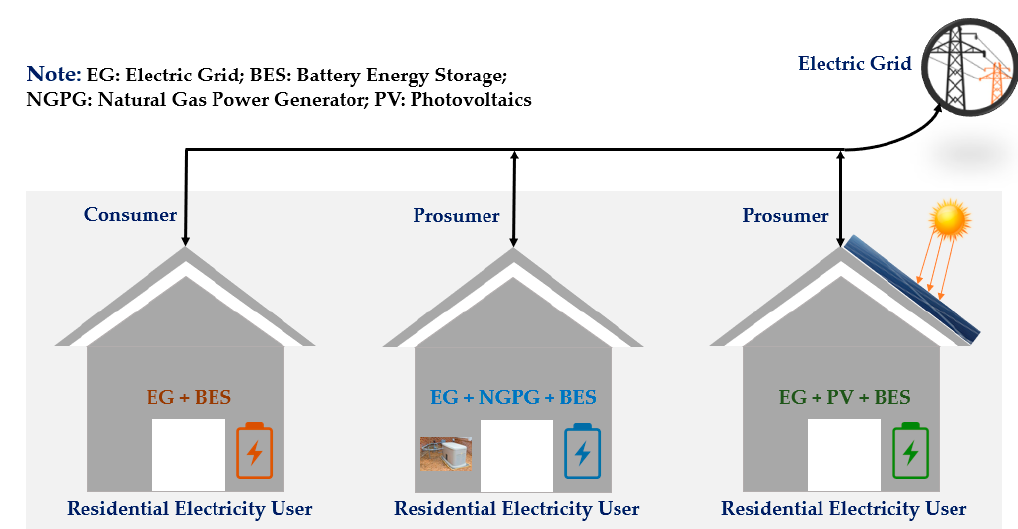
Figure 4. Schematic view of the proposed three power supply system configurations for residential electricity users [Note: EG—Electric grid; BES—Battery energy storage; NGPG—Natural gas power generator; PV—Photovoltaics.]